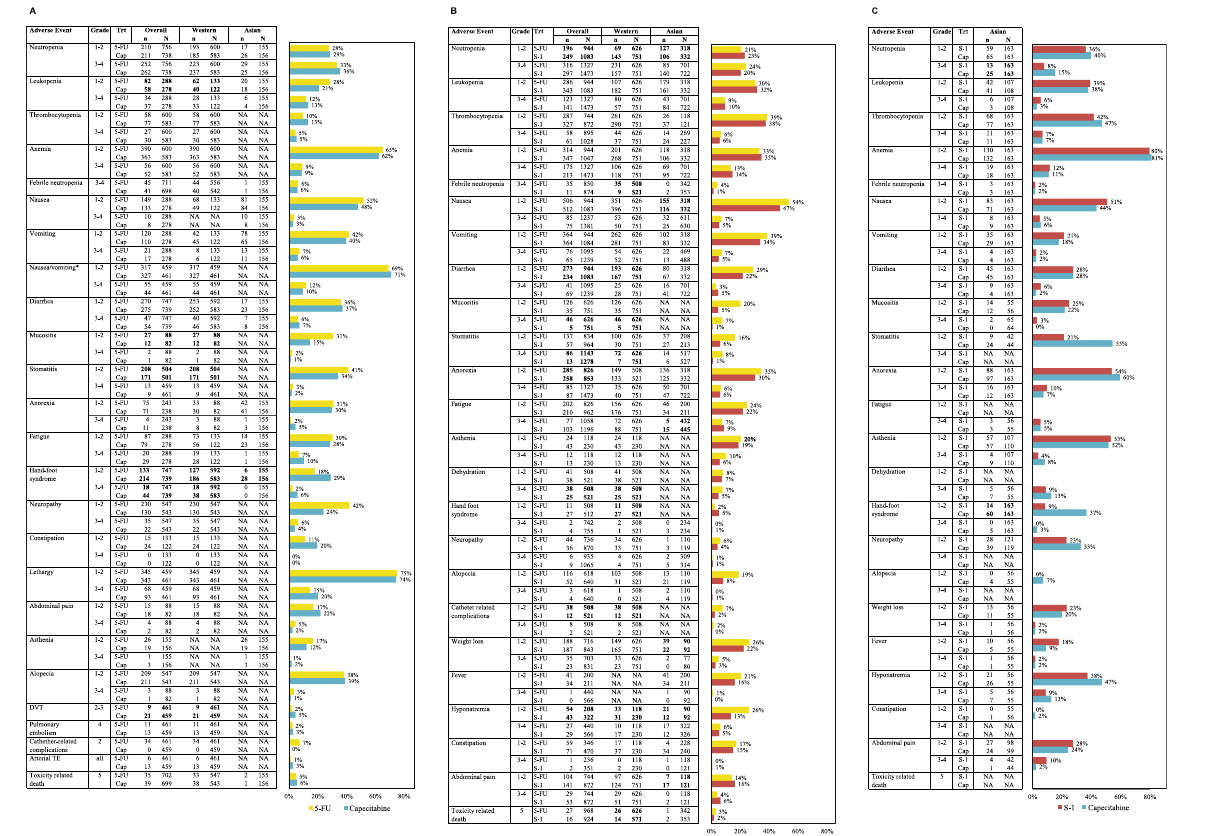
Figure 4. Toxicity of capecitabine, 5-FU and S-1 based regimens. ( A ) Toxicity of capecitabine-based compared to 5-FU-based regimens. ( B ) Toxicity of S-1 based compared to 5-FU-based regimens. ( C ) Toxicity of S-1 based compared to capecitabine-based regimens. The table shows the number of patients receiving that experienced grade 1-2 and grade 3-4 adverse events and the associated sample sizes for each treatment. The bar chart shows the percentage of both Western and Asian patients (overall) that experienced grade 1-2 and grade 3-4 adverse events and corresponds to the ‘overall’ column in the table. The number of adverse events that occurred in the Western subgroup or the Asian subgroup specifically are shown in the ‘Western’ and ‘Asian’ columns of the table. Bold indicates a statistically significant difference (P < 0.05) in a the occurrence of a given adverse event between two regimens determined by pair-wise meta-analysis. The number of adverse events for Western and Asian patients in Fig. 4B and C are a graphically representation of the data as published elsewhere 6 . However, in the current figures, additional adverse events were included, as well as the pooled number of adverse events of Western and Asian patients. Abbreviations: 5-FU: 5-fluorouracil, Cap: capecitabine, Trt: